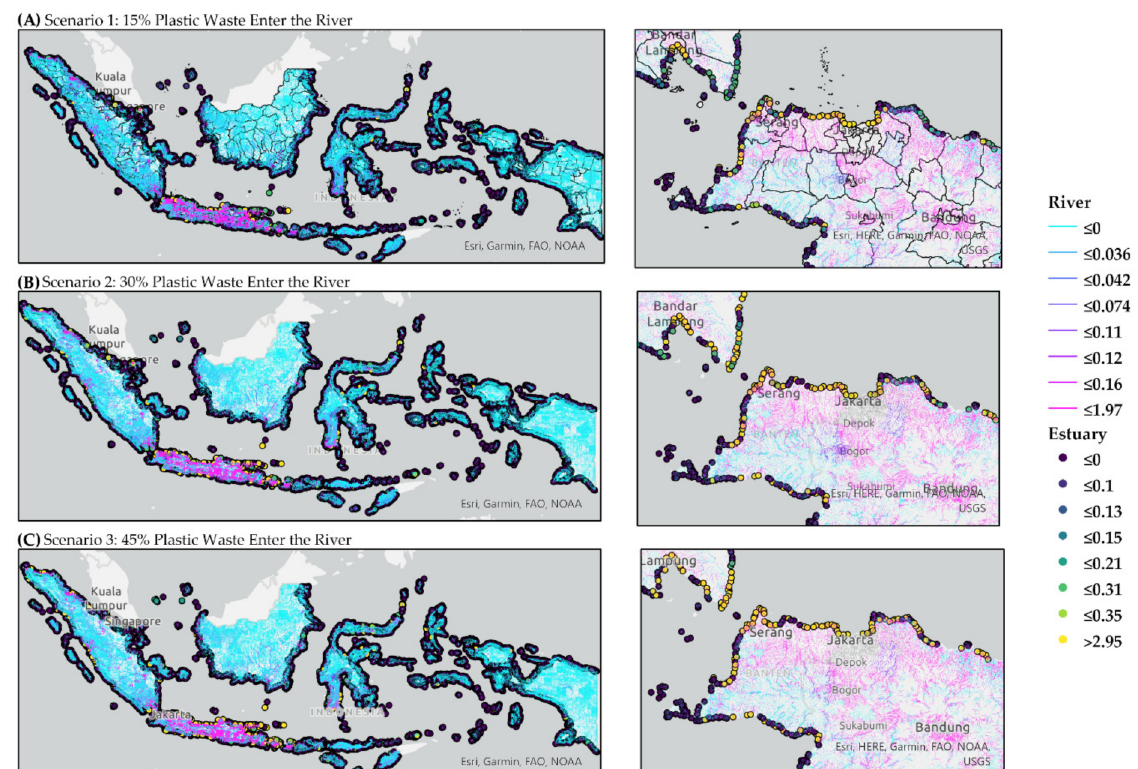
Figure 9. Developing scenarios of plastic waste from streamflow through an estuary: ( A ) low case scenario in 15%; ( B ) moderate case scenario in 30%; ( C ) high case scenario in